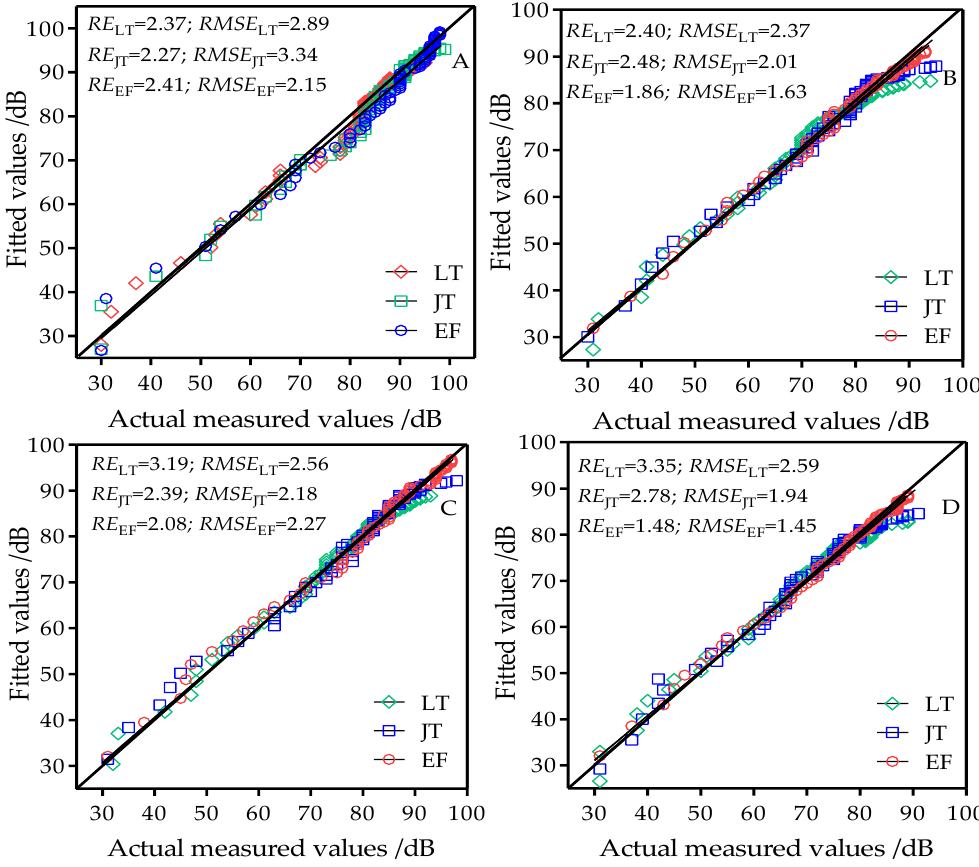
Figure 6. Comparison chart of fitted values from the one-slope log-distance model and actual measured values at antenna heights of ( A ) 0.8 m; ( B ) 1.2 m; ( C ) 1.6 m; and ( D ) 2.0 m; LT: tillering stage; JT: jointing stage; EF: grain filling stage.